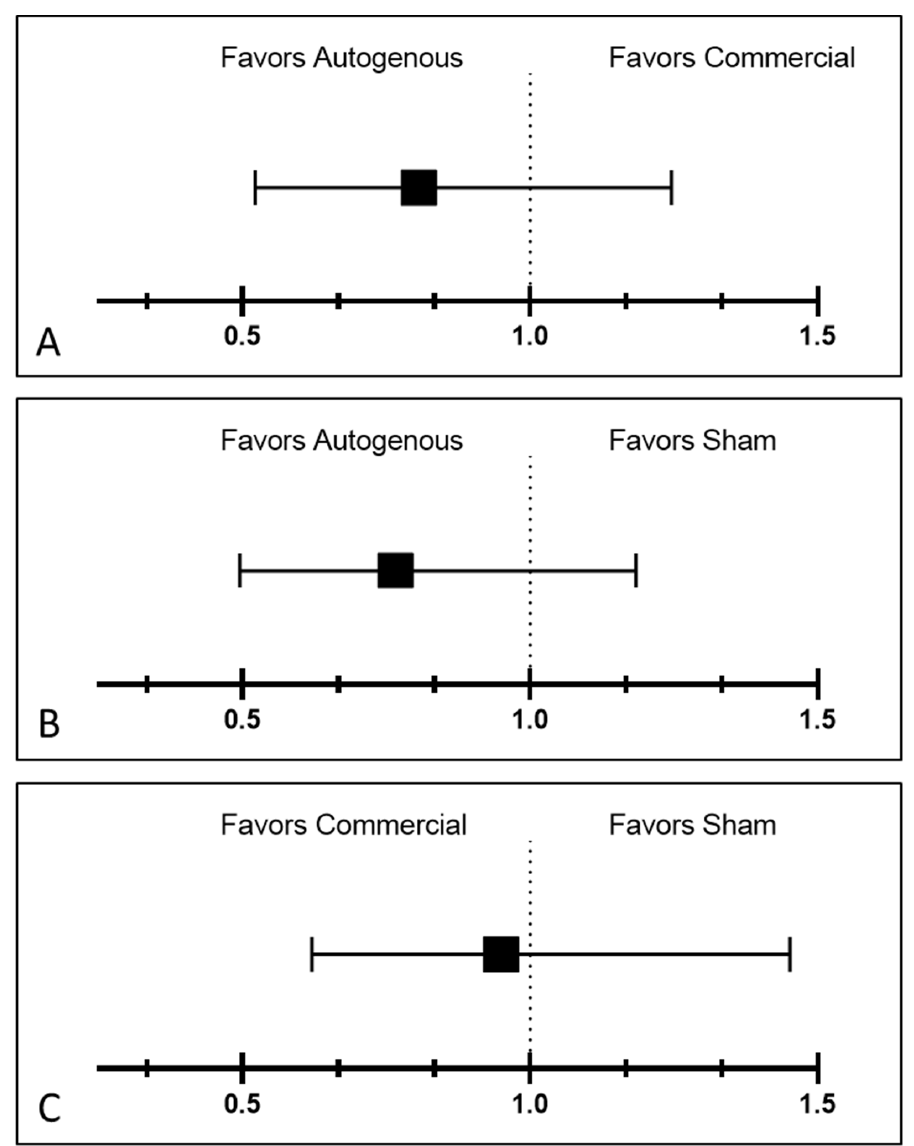
Figure 4. Risk ratio for the effect of treatment on incidence of IBK for the vaccine comparisons in this study. 4 ( A ): Autogenous vs. Commercial: RR = 0.8066 (95% CI 0.5223–1.2455). 4 ( B ): Autoge-